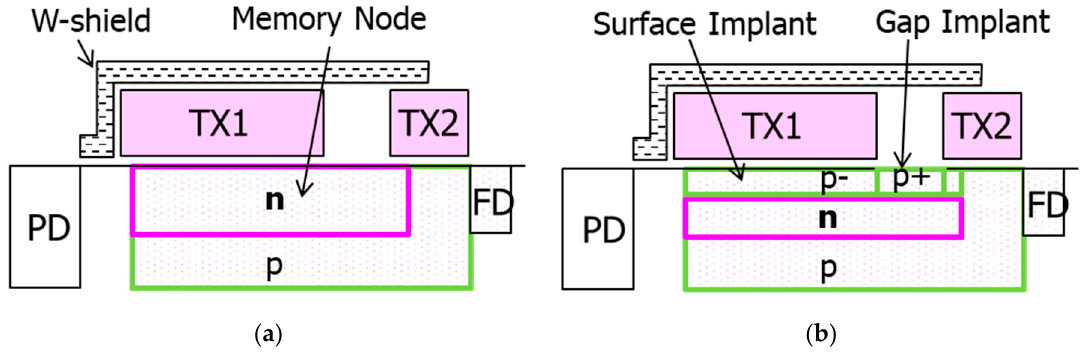
Figure 4. Cross-section schematics of ( a ) conventional memory node (MN) and (b ) full pinned MN.